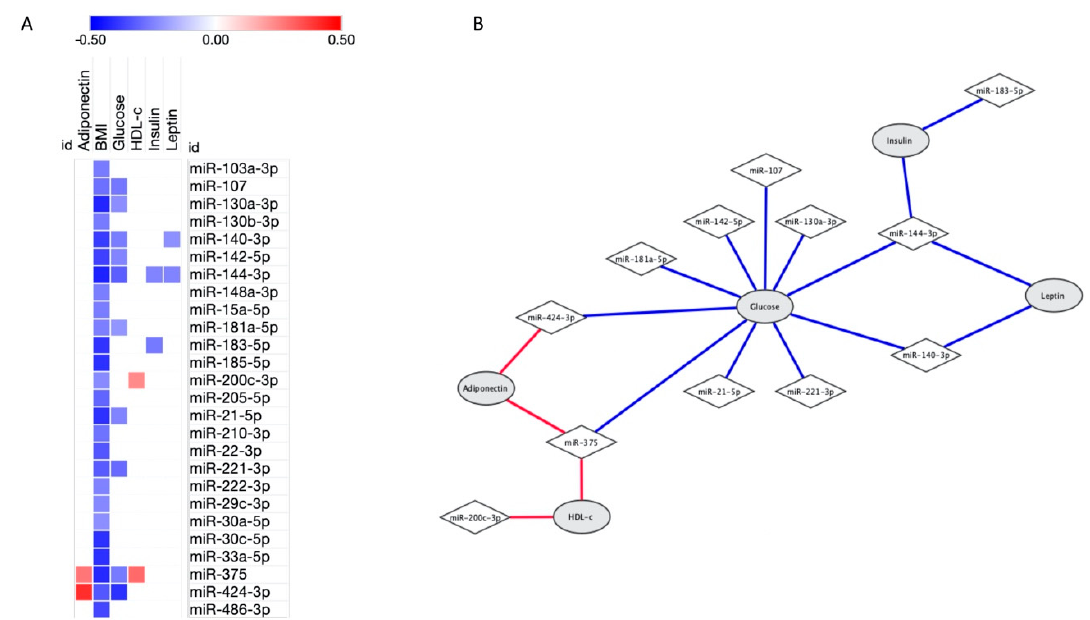
Figure 1. Significant correlations between 26 microRNAs associated with obesity and laboratorial characteristics. ( A ) Heatmap showing the correlations between microRNAs expression (in rows) and characteristics (in columns). Positive correlations were highlighted in red, negative correlations in blue and lack of correlation in white; brighter shades indicate higher correlations. ( B ) Network demonstrating correlation between microRNAs and laboratorial characteristics. Of note, all microRNAs also correlated with body mass index (BMI). Correlations analysis were performed using Pearson. Table 2. Relation of 26 microRNAs whose expression profile in plasma is significantly different between cases with obesity and eutrophic controls.